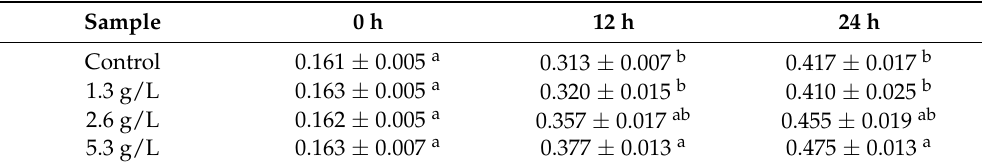
Table 2. Least square means for protease activity (absorbance) of Lactobacillus bulgaricus LB-12 as influenced by carao concentration over an incubation period of 24